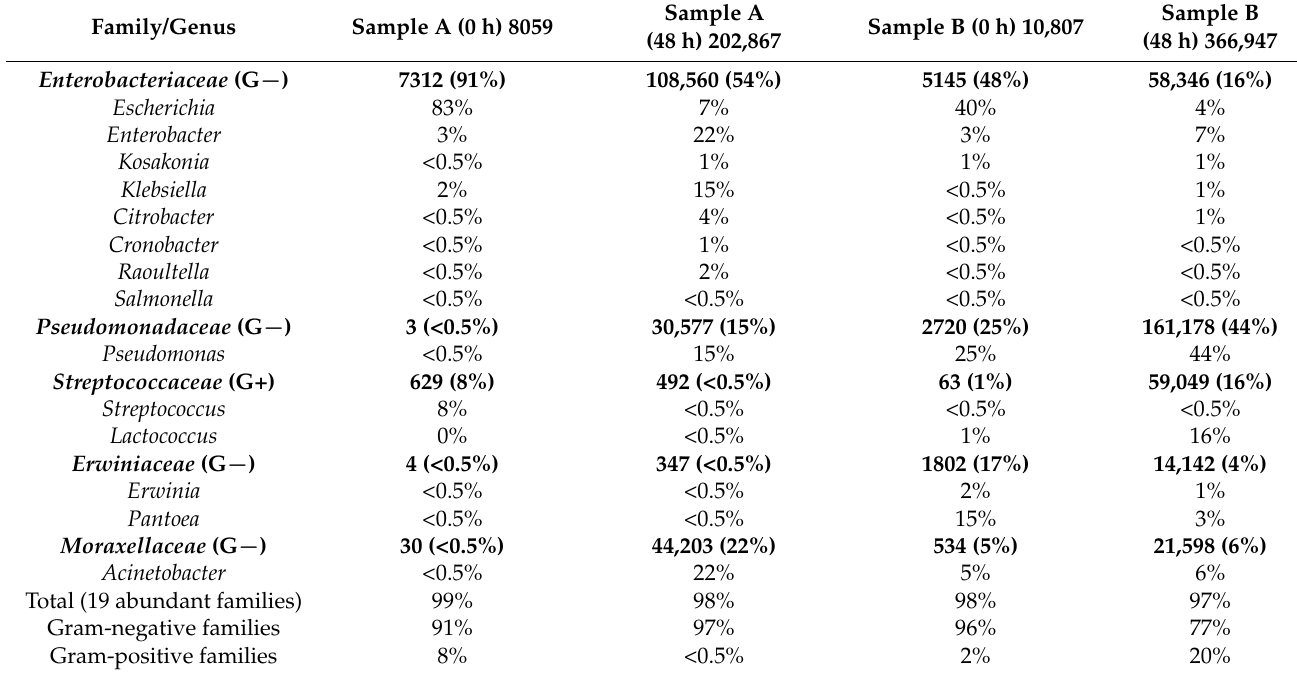
Table 2. Family diversity of bean sprouts: the five most abundant families (detected in any sample with abundance reads over